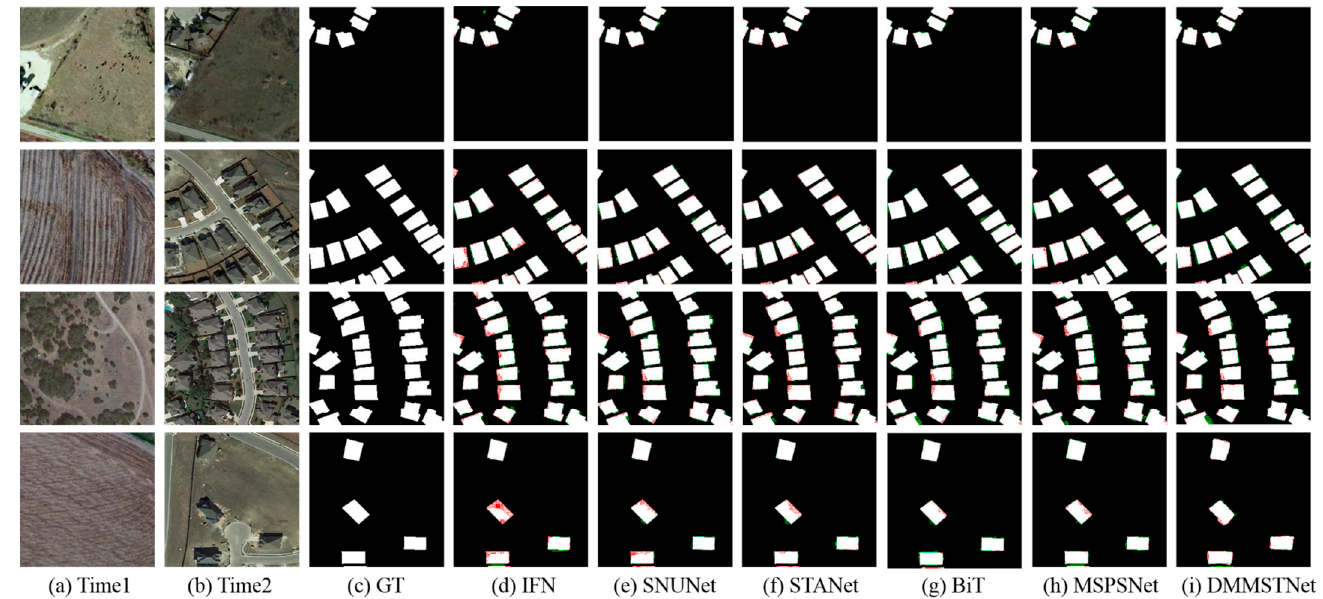
Figure 8. Visualization on the LEVIR-CD dataset. ( a ) The images at time1. ( b ) The images at time2. ( c ) The ground truth. ( d ) The results of IFN. ( e ) The results of SNUNet. ( f ) The results of STANet. ( g ) The results of BiT. ( h ) The results of MSPSNet. ( i ) The results of DMMSTNet. The true positives are marked in white color, the true negatives are marked in black color, the false positives are marked in red color and the false negatives are marked in green color. Table 2. Numerical Results on CCD